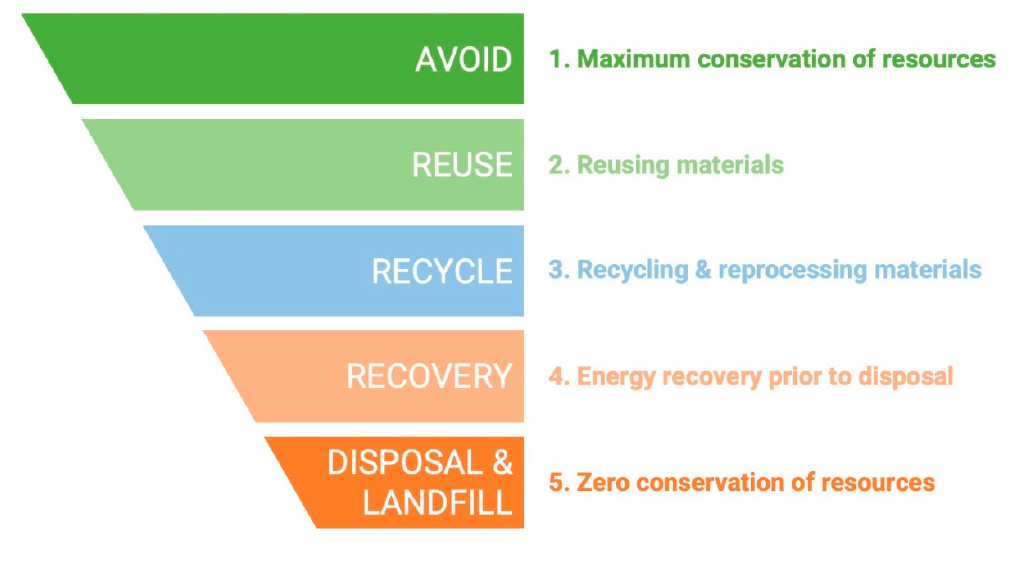
Figure 1. Hierarchy for waste processing.